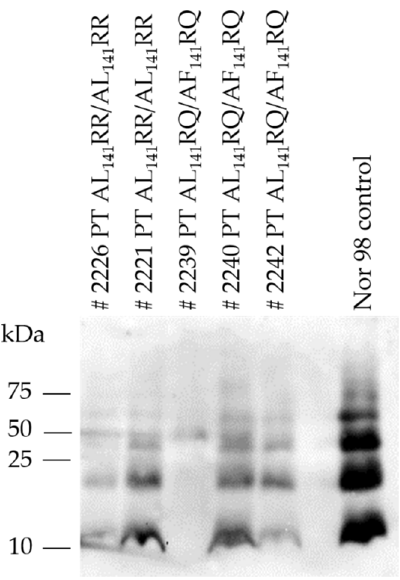
Figure 3. Western immunoblot of PrP Sc from brains of transgenic TgshpXI mice inoculated with Portuguese (PT) atypical scrapie isolates (# indicating mouse ID). Nor98 atypical scrapie was included as a control and displayed the characteristic atypical prion protein banding pattern with 4–5 bands of fragment sizes 12–60 kDa.